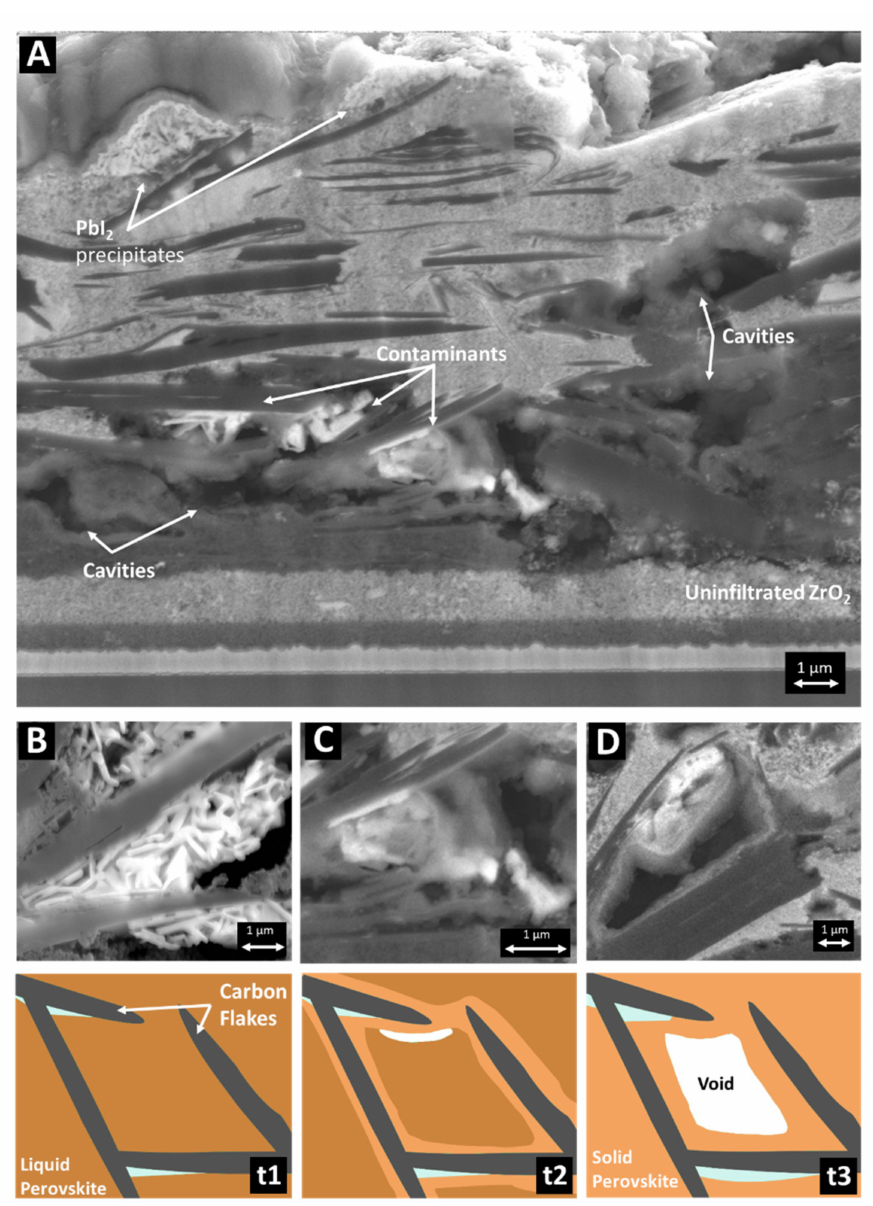
Figure 5. ( A ) An example of a poorly infiltrated carbon stack with key defects identified; ( B ) residual PbI2 precipitates; ( C ) contaminants (Pb free); ( D ) infiltration cavity with some retained PbI2. In t1–t3, schematics of MAPI in DMSO (brown) infiltrated into mesoporous carbon (grey) are shown: t1, fresh infiltration; t2, drying perovskite that solidifies first around the carbon preventing further liquid infiltration; t3, a shrinkage cavity within the